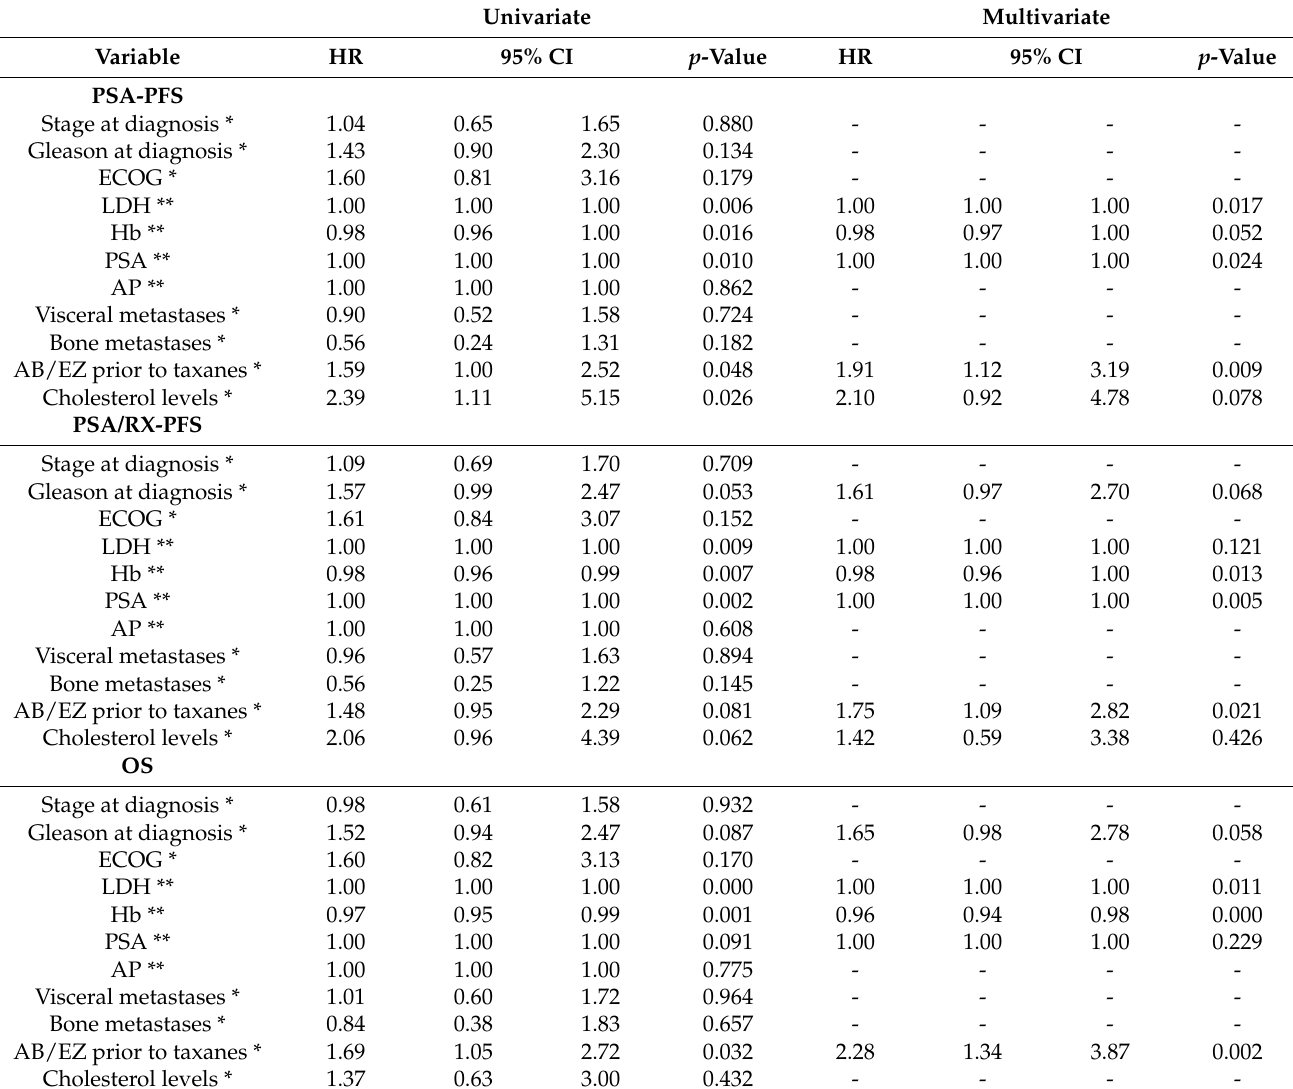
Table 3. Univariate and multivariate Cox models for PSA-PFS, PSA/RX-PFS and OS in patients from the plasma sample cohort adjusted for clinically significant variables ( p < 0.1) in the univariate